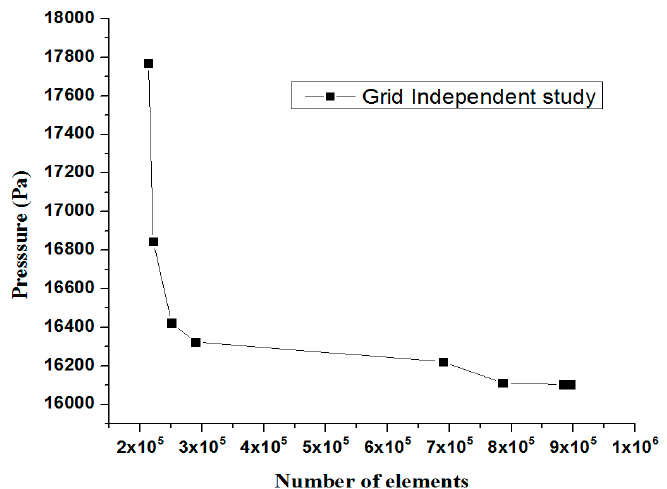
Figure 5. Mesh independent study for pressure along the diastolic condition (0.55 s).